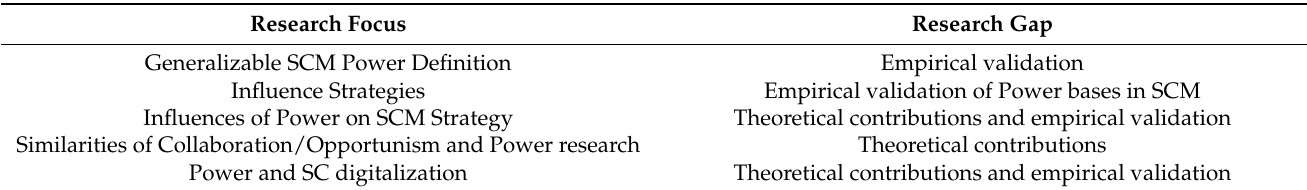
Table 4. Research gaps concerning power in